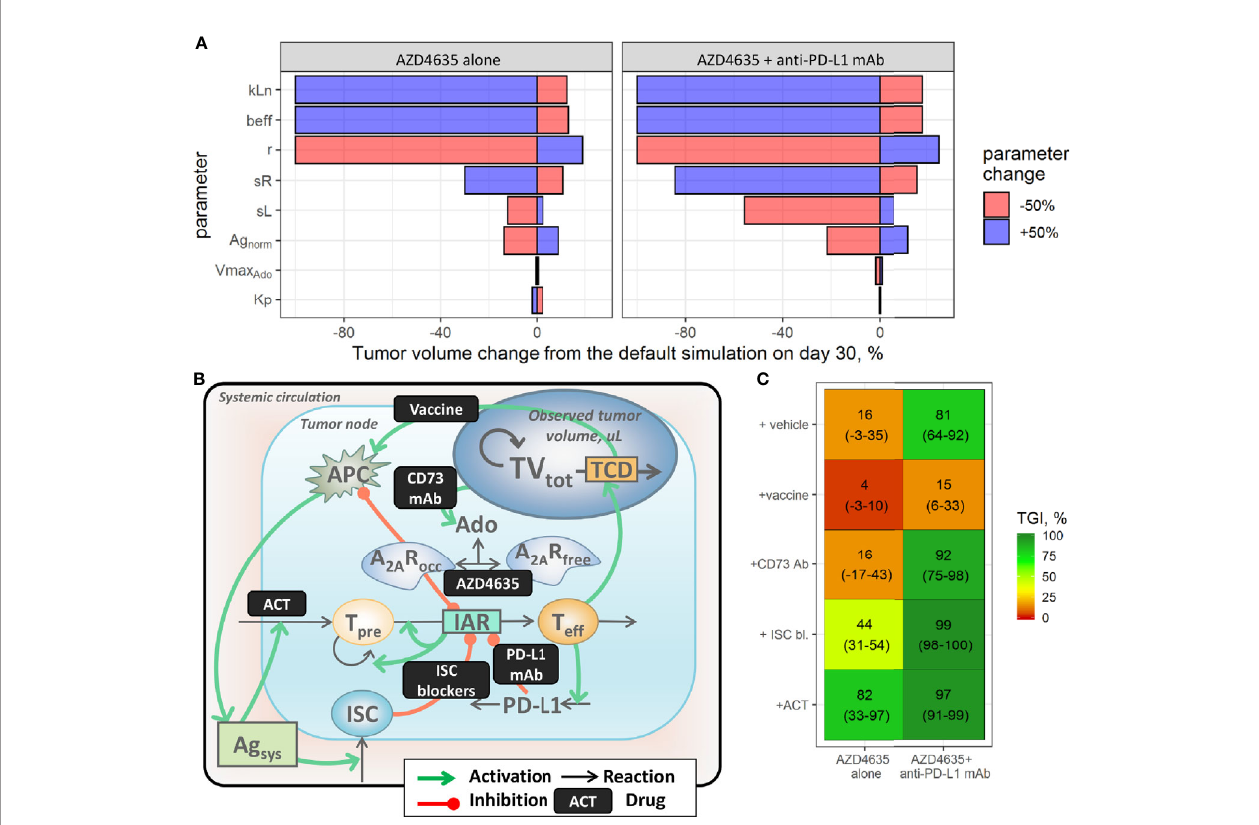
FIGURE 4 | Evaluation of combination strategies for AZD4635. (A) Identi fi cation of factors affecting the ef fi cacy of AZD4635 alone or in combination with a PD-L1 mAb; colors denote parameter change. (B) Implementation of considered treatment options in the model. (C) Predicted tumor growth inhibition index (TGI; mean and 90% con fi dence intervals); colors denote median